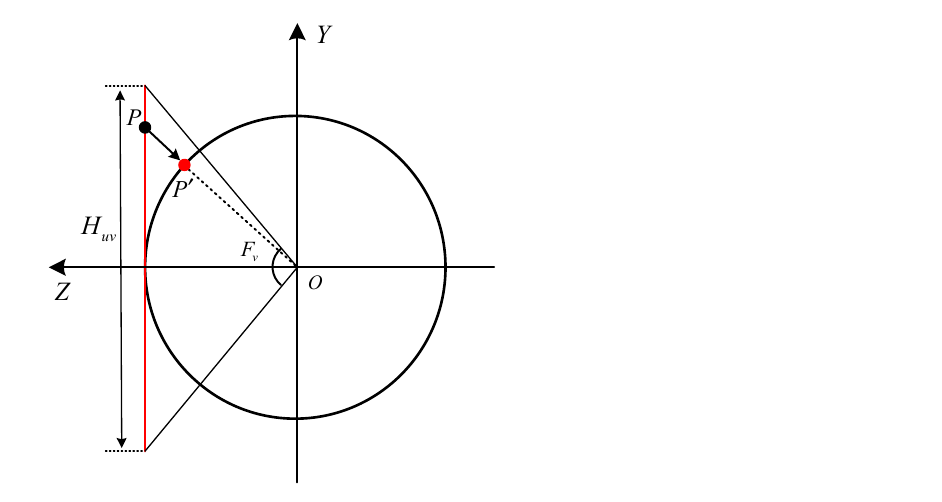
Figure 3. Cross-section of the UV plane and sphere when the perspective projection is used. Point P is projected onto point P (cid:48) on the unit sphere, where the coordinates ( X, Y, Z ) of P (cid:48) can be determined as follows: